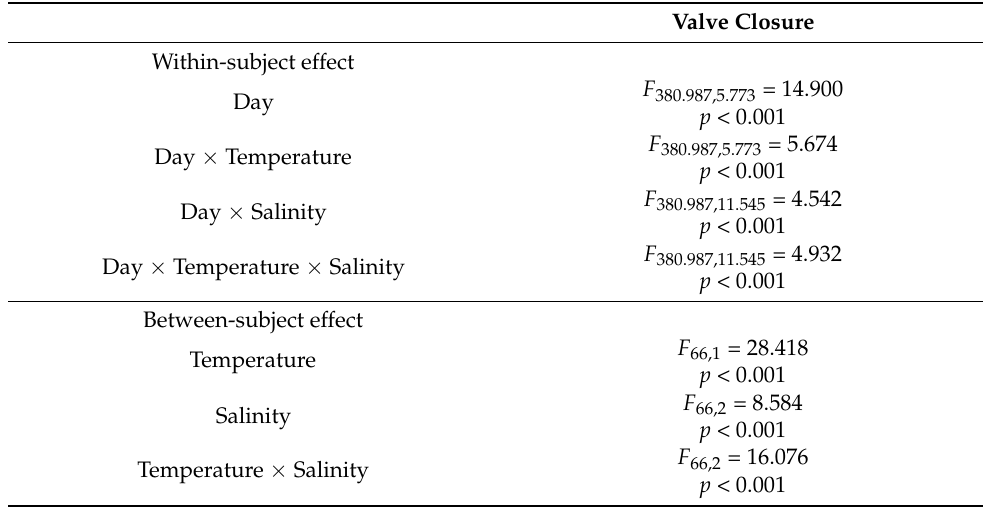
Table 1. Results of the two-way repeated-measures ANOVA for the effects of temperature and salinity on the valve closure of Venerupis philippinarum